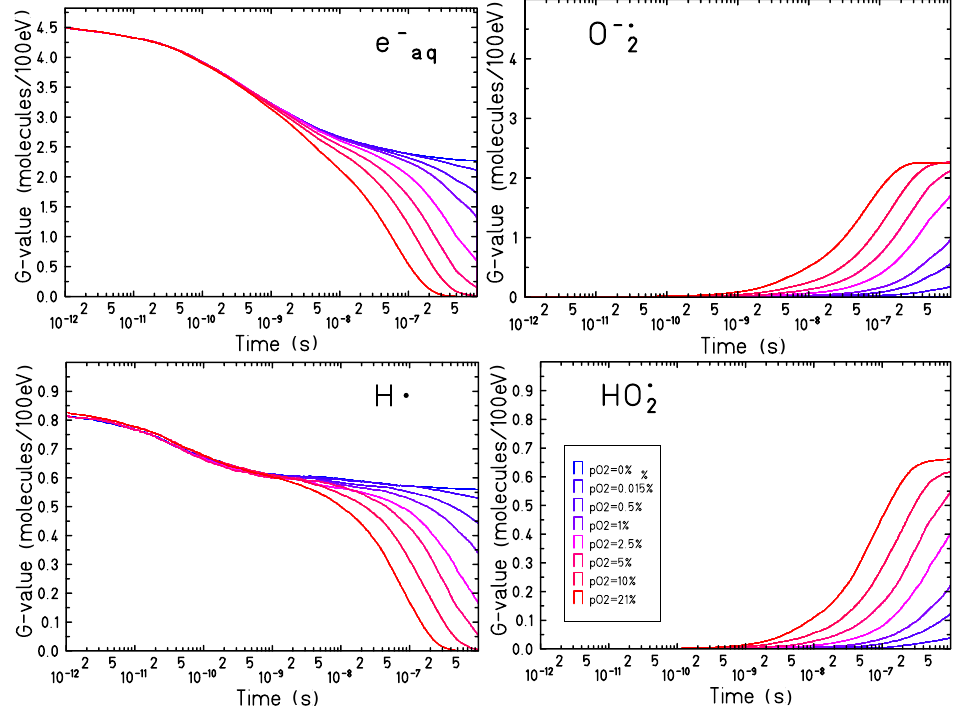
Figure 3. Time dependent yield for e − aq ( top left ), H • ( bottom left ), O •− HO • ( bottom right ) in an oxygenated water target, with oxygen concentration on the water surface 2 between pO 2 = 0% and pO 2 = 21%, for 500 keV electron